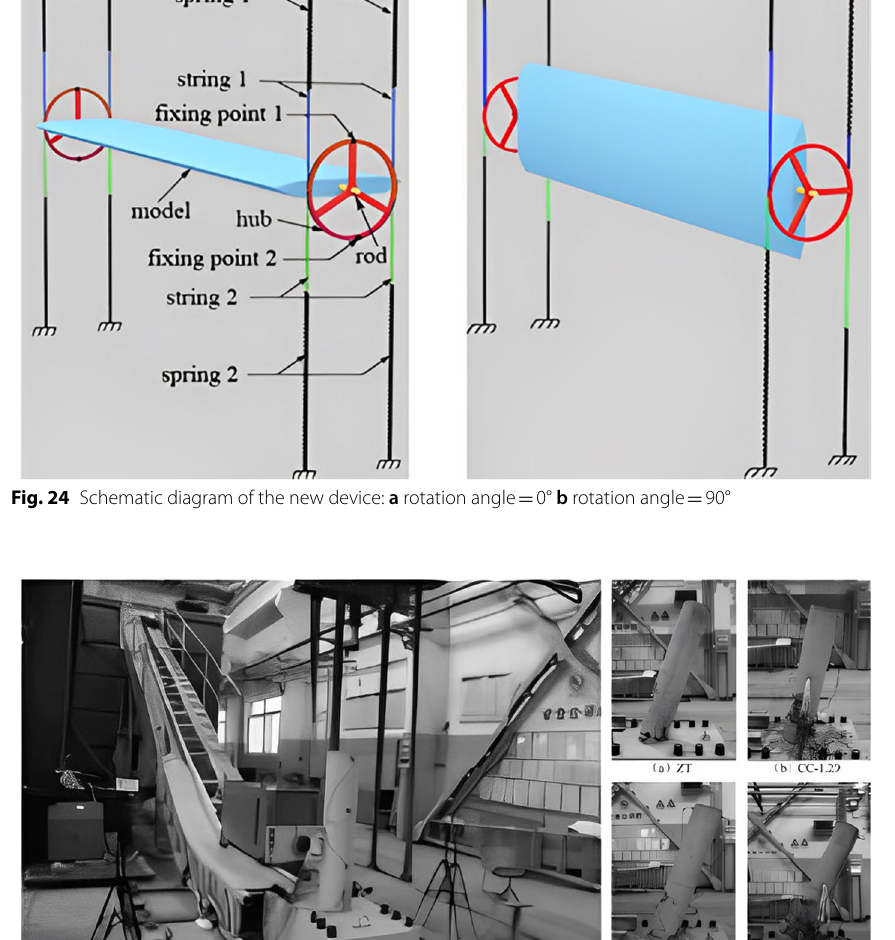
Fig. 25 Dynamic model test of socket assembled pier under vehicle